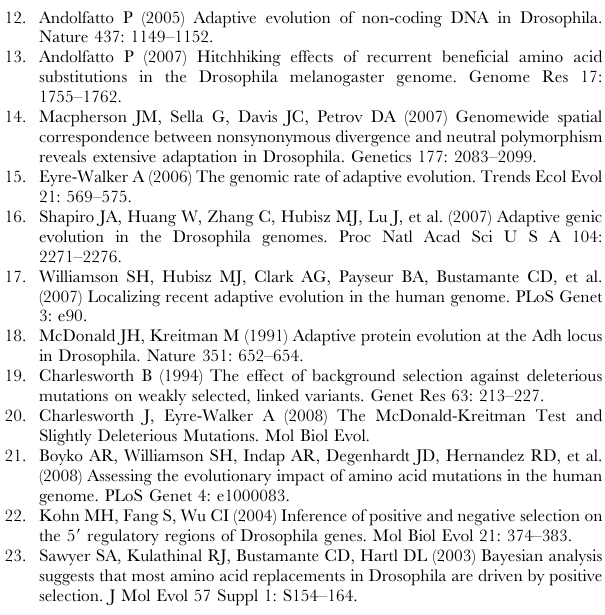
divergence at conserved noncoding region ( D x ), the number of codons ( FD n ), the number of conserved noncoding sites ( FD x ), and the level of neutral divergence ( d neu ). Spearman’s r and Kendall’s t are given at the upper and lower diagonal parts of the table, respectively. The values of h neu and P neu are based on the Watson data. Table S2 Correlation coefficients and partials correlation coefficients between recombination rate (RR) and levels of neutral polymorphism [i.e., the level of neutral polymorphism ( h neu ) and the level of normalized neutral polymorphism ( P neu = h neu / d neu )]. Spearman’s partial correlation coefficients were calculated by controlling for all possible combinations of potentially confounding variables. The results of representative combinations are given here. Closed circles ( N ) indicate the controlled variables. These variables are GC content (GC), the density of simple repeats (RD), the divergence at coding sites ( D n ), the divergence at conserved noncoding region ( D x ), the number of codons ( FD n ), the number of conserved noncoding sites ( FD x ), and the level of neutral divergence rate ( d neu ). Open circles ( # ) indicate the variables that were not controlled in a particular analysis. (P) indicates the results are based on the Perlegen data, (W) indicates the results are based on the Watson data. P -values are given in parentheses. Table S3 Spearman rank correlation coefficients and partials correlation coefficients between functional divergence [i.e., the divergence at coding sites ( D n ) or the divergence at conserved noncoding region ( D x )] and neutral polymorphism [i.e., the level of neutral polymorphism ( h neu ) and the level of normalized neutral polymorphism ( P neu = h neu / d neu )], and between functional con- straints [i.e., the number of codons ( FD n ) and the number of conserved noncoding sites ( FD x )] and neutral polymorphism ( h neu and P neu ). Spearman’s partial correlation coefficients were calculated by controlling for all possible combinations of potentially confounding variables. The results of representative combinations are given here. Closed circles ( N ) indicate the controlled variables. These variables are GC content (GC), the density of simple repeats (RD), the divergence at coding sites ( D n ),